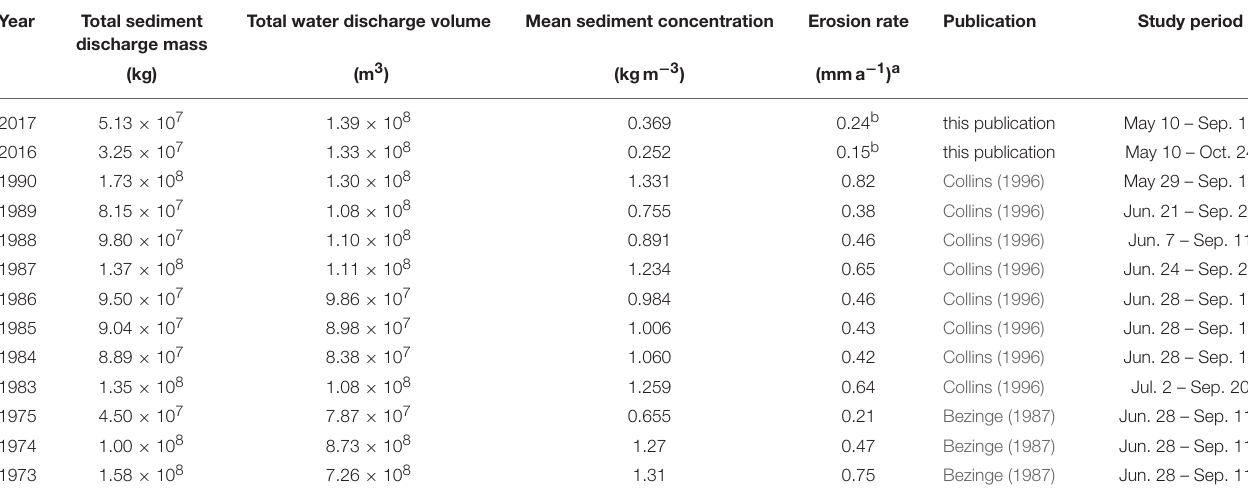
TABLE 1 | Summary of annual sediment and hydrological data from the Gornergletscher